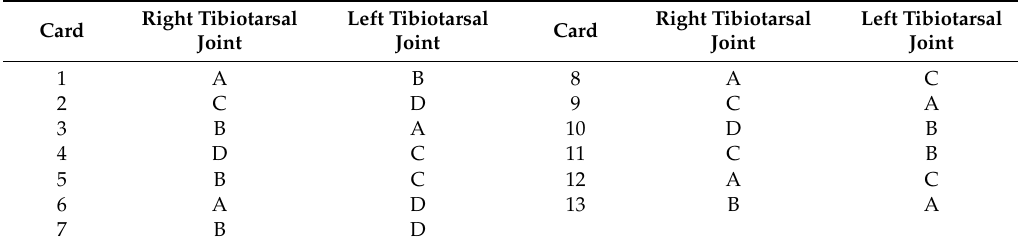
Table 1. Randomization of the sequence